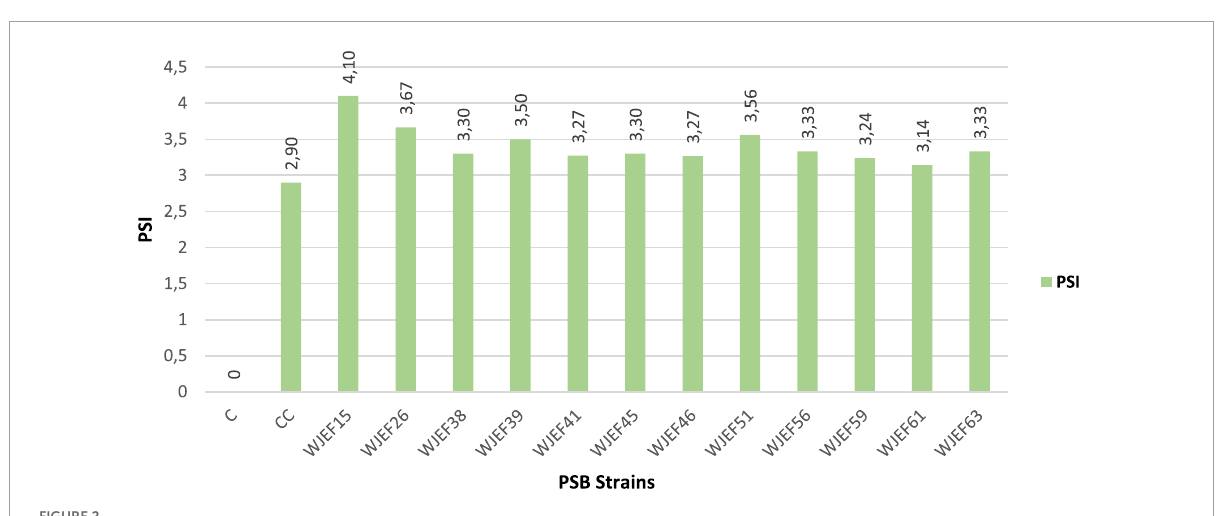
FIGURE2 Phosphate solubilization index (PSI) of isolated strains on solid NBRIP